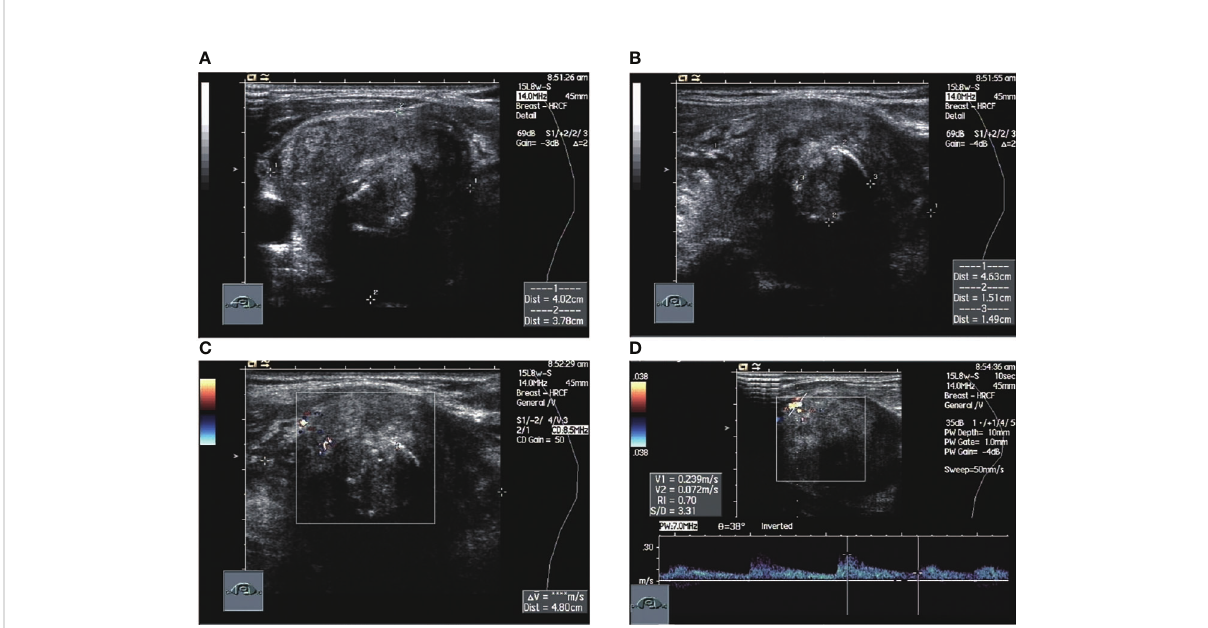
FIGURE 3 Ultrasound images of patient #5 in which normal thyroid tissue is no longer visible. The nodule occupies the entire image, with annular calci fi cations visible within it and a relatively rich local blood fl ow signal of RI=0.7. This patient had a recurrence 2 months after surgery, was treated with radiation after a second operation and was fi nally lost to follow-up. (A) Sagittal scan (B) Transverse scan (C) CDFI (D) Pulsed